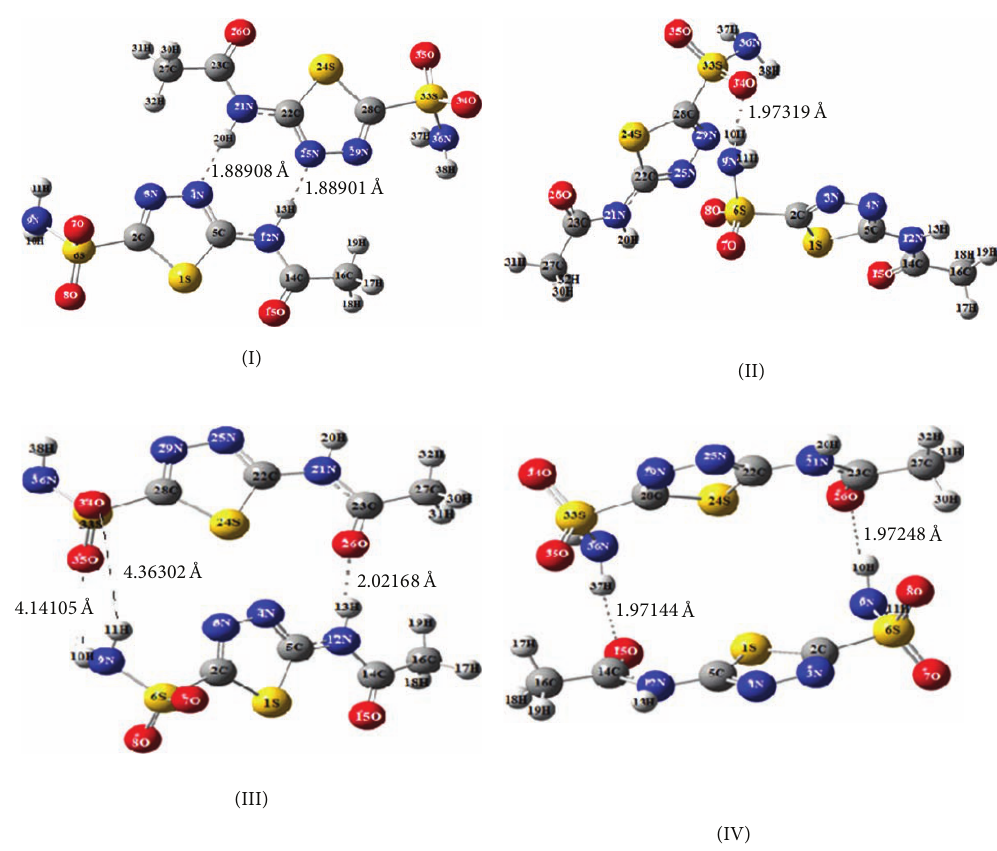
Figure2:Theenergyminimizedstructuresoffourlowenergyconformers(I–IV)ofthedimerformsoftheacetazolamide,(I–IV),respectively. O clusters (I–IX). (b) The counterpoise uncorrected and corrected Table 1: (a) The calculated energies of monomeric, dimeric (I–IV), and H 2 interatomic distance (˚A) and binding energy (kcal/mol) of dimer I. (a) Calculated energy (kcal/mol) Energy differences